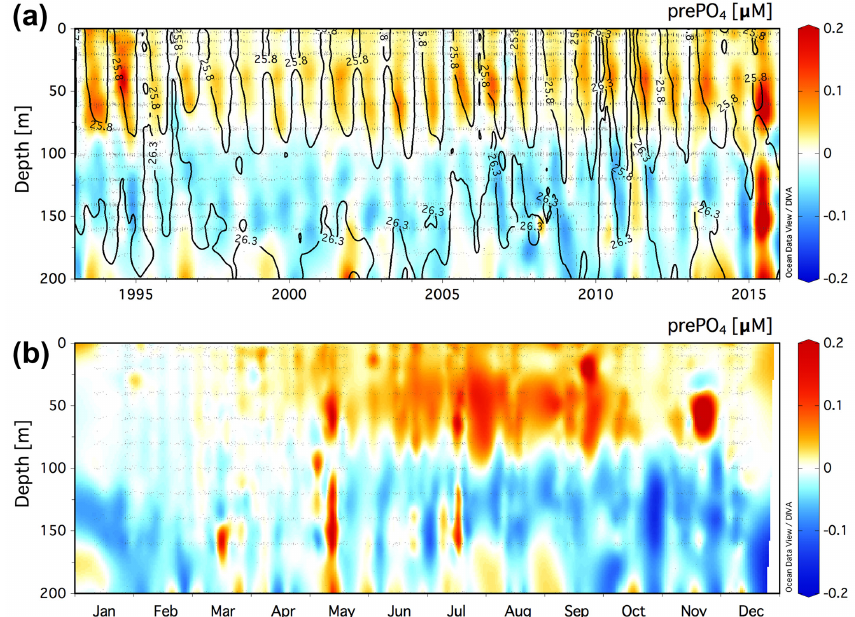
Figure 4. (a) Climatology of the residual prePO 4 tracer [µM] in the upper 200m at the BATS station (31.67 ◦ N, 64.17 ◦ W) for a value of r POM = 10 . 6. Black contour lines show neutral density, γ n = 25 . 8 and 26.3. (b) The monthly averaged residual prePO 4 [µM] climatology for all data in the years